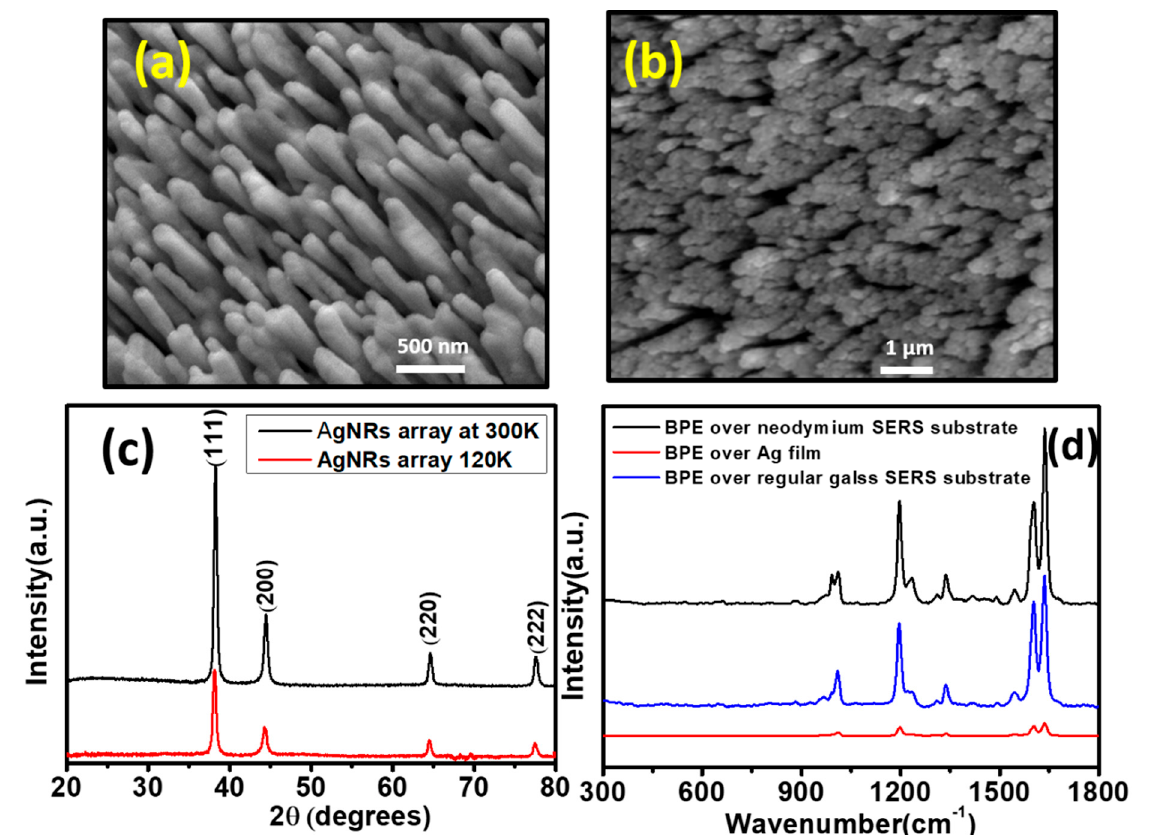
Figure 3. ( a ) SEM images of AgNRs over glass substrates at room temperature (300 K). ( b ) SEM images of AgNRs at 120 K deposited using GLAD technique. ( c ) XRD pattern for the two AgNR SERS substrates. ( d ) Comparison of the Raman and SERS spectra of BPE analyte over the three different substrates (c-SERS and M-SERS substrates, and 200 nm thin Ag film). Reproduced with permission from